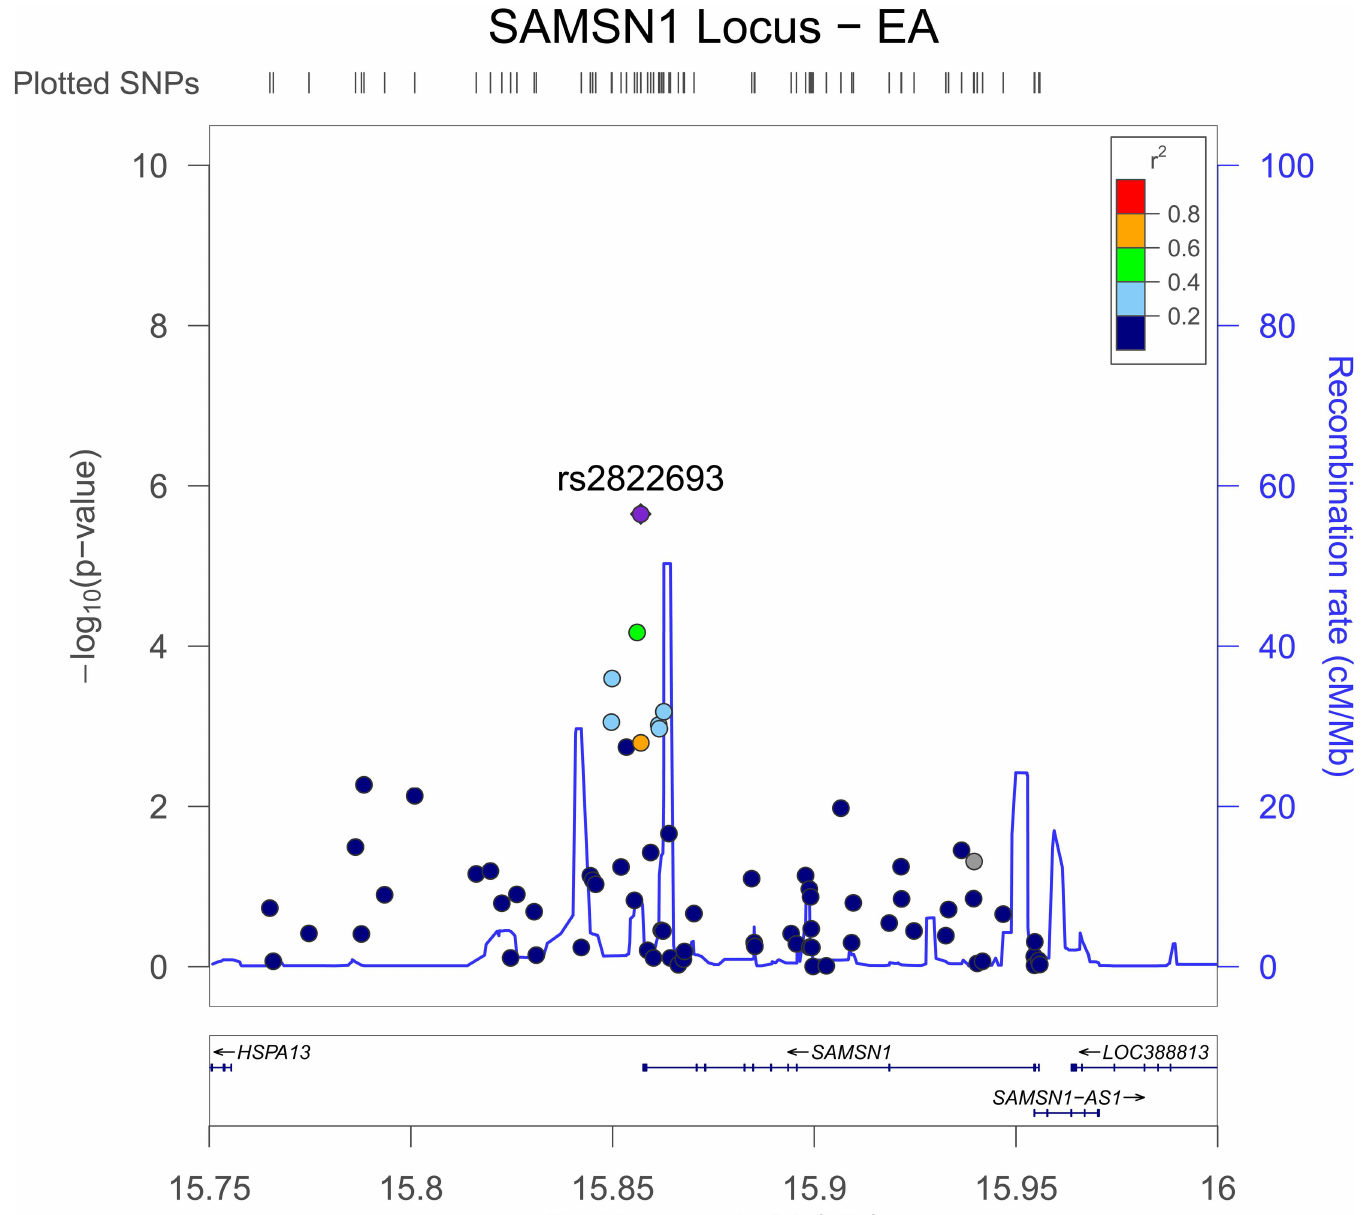
Fig 3. LocusZoom Plot of Open Chromatin Region Downstreamof SAMSN1 for EA GWIS. Overall the LD across the regionis modest to low supporting the hypothesisthat the interaction associationsignal is coming from rs2822693or an untypedvariant in high LD with it, likely restricted to the regionbetweenthe two recombination peaks. For plotting1000 Genomes data was used (population= EUR) in genome build hg19.